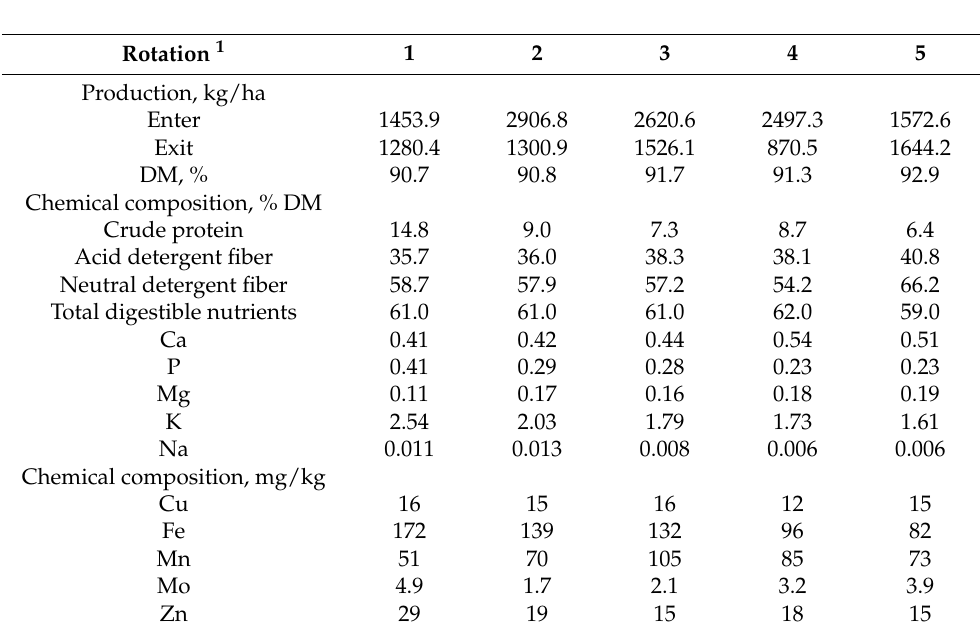
Table 2. Heifer pasture (1–5) forage quality and production at the time of entry and exit at the Montana State University Fort Ellis research farm.